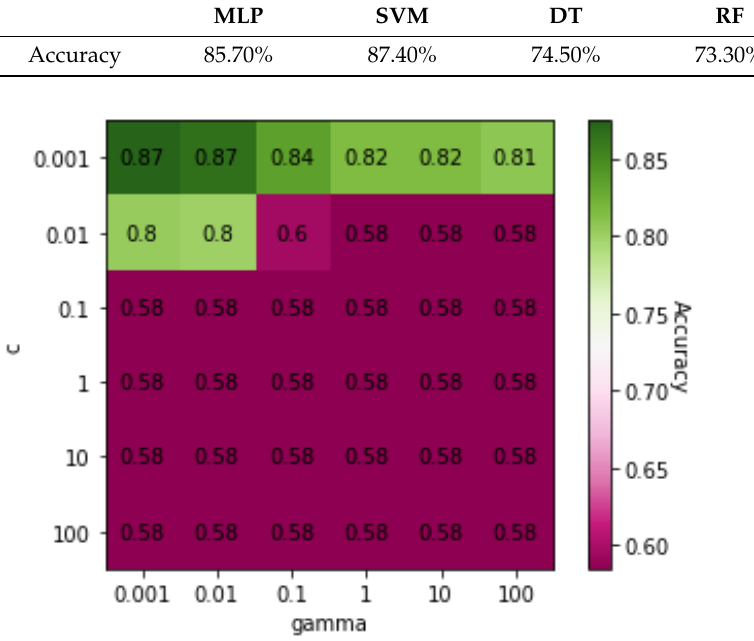
Figure 1. Heatmap of values of SVM parameters C and γ on Dataset 01.